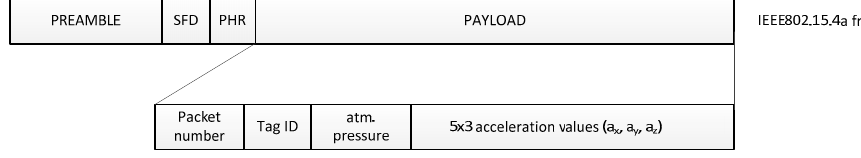
Figure 4. Tag’s frame payload.